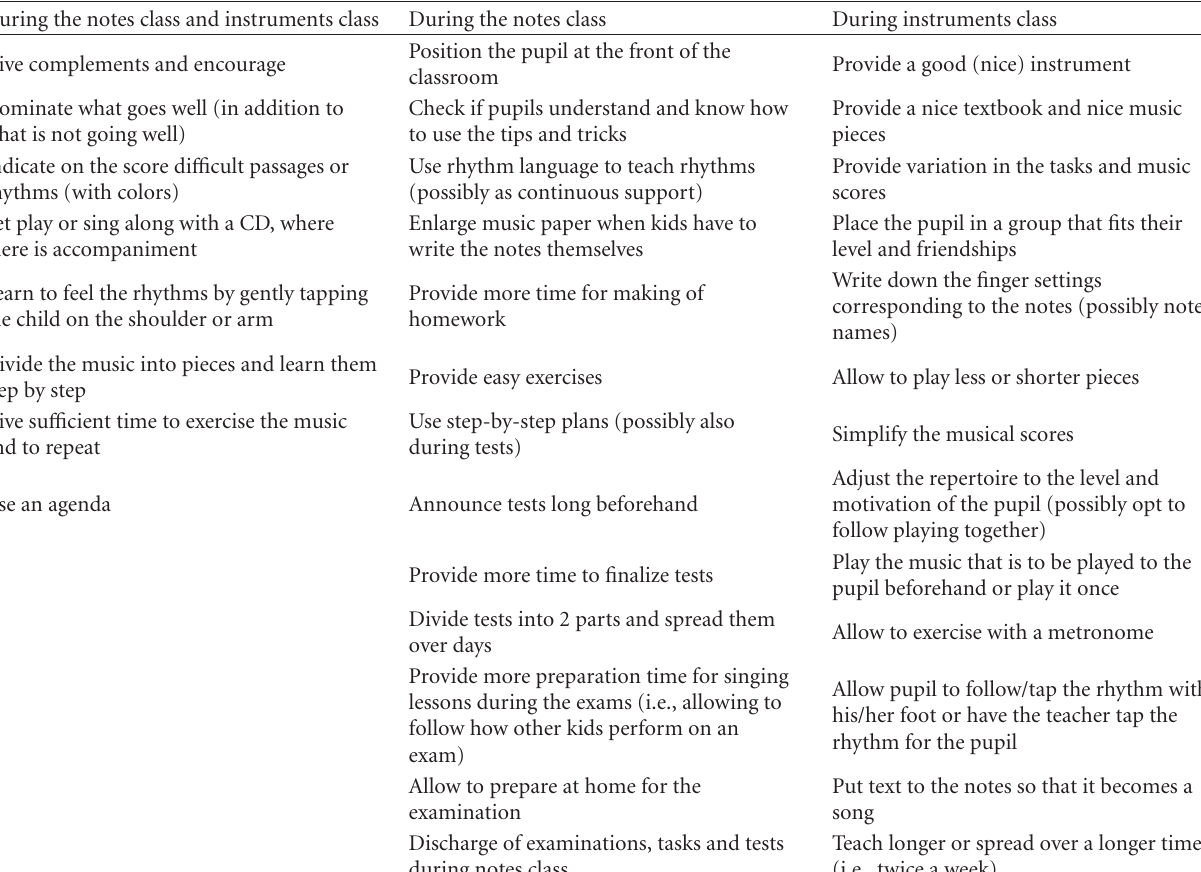
Table 1: STICORDI for music teaching in children with and without